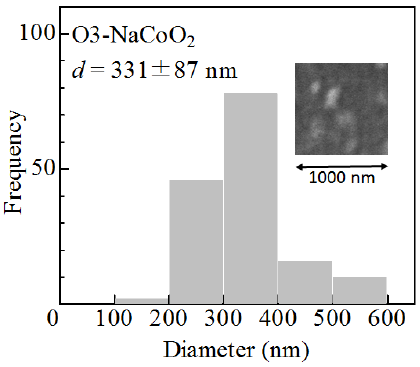
Figure 4. Histogram of the particle size ( d ) of the as-grown O3-NaCoO 2 film. Inset shows scanning electron microscopy (SEM) images of the